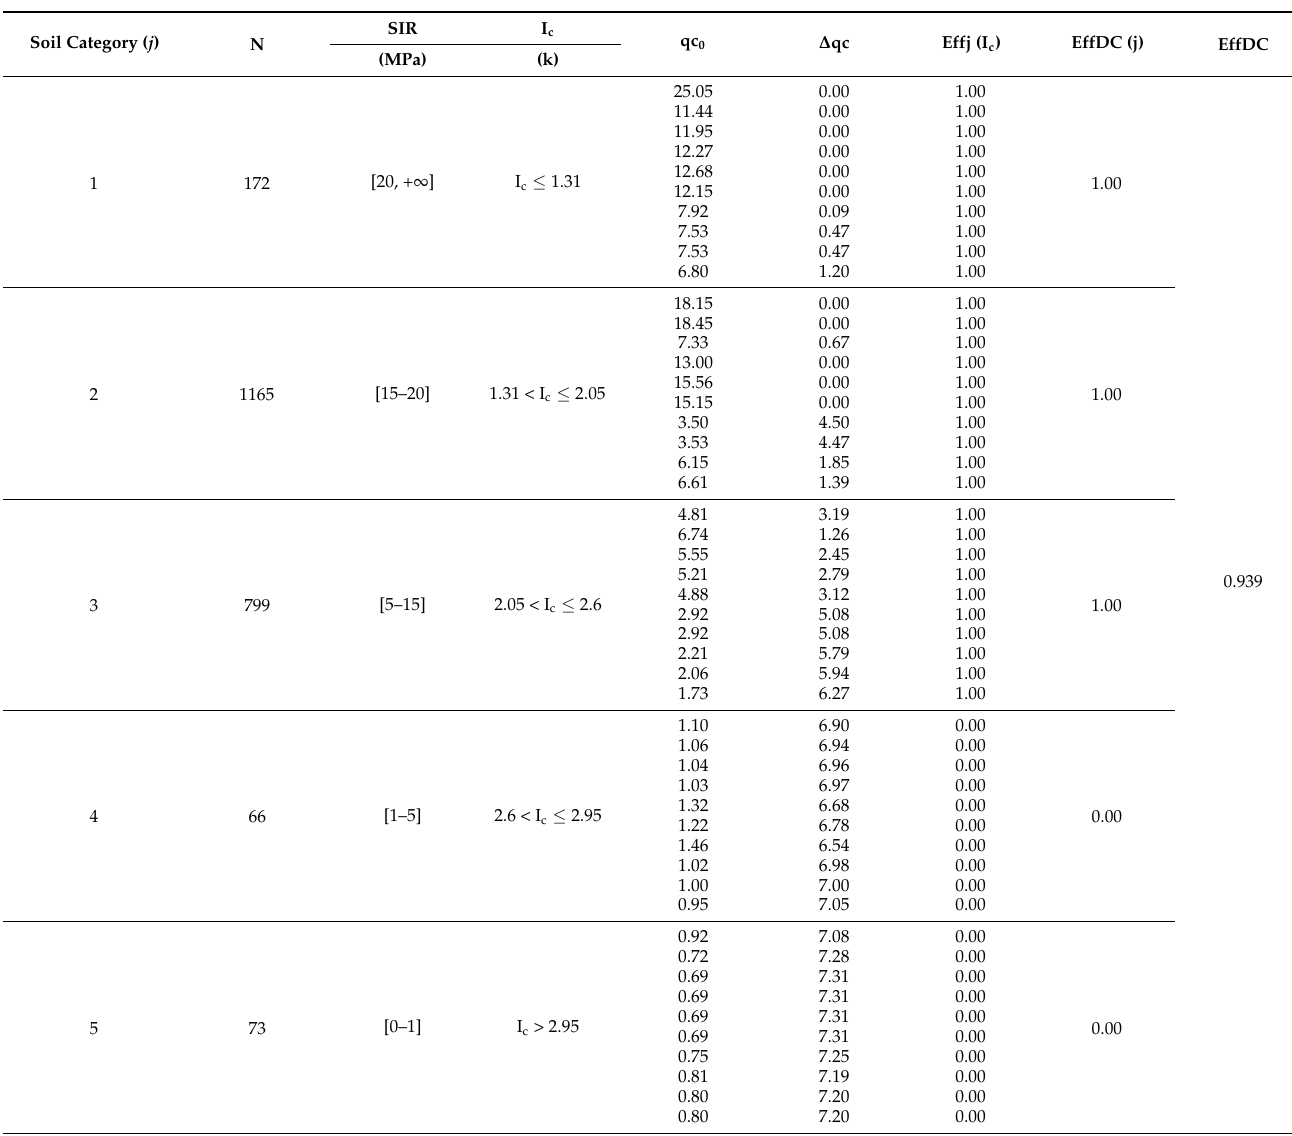
Table 3. DC Effectiveness for each soil category in the